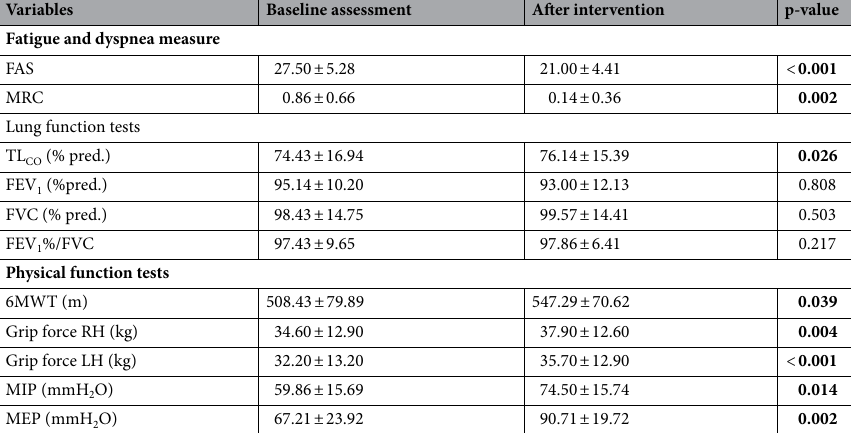
Table 2. Clinical features of the patients with sarcoidosis at baseline and after exercise training. Data are expressed as absolute number or mean ± standard deviation (SD). FAS Fatigue Assessment Scale, MRC Medical Research Council questionnaire, TL CO transfer factor for carbon monoxide, % of predicted, FEV 1 forced expiratory volume during the first second, FVC forced vital capacity, 6MWT six-minute walk test, RH right